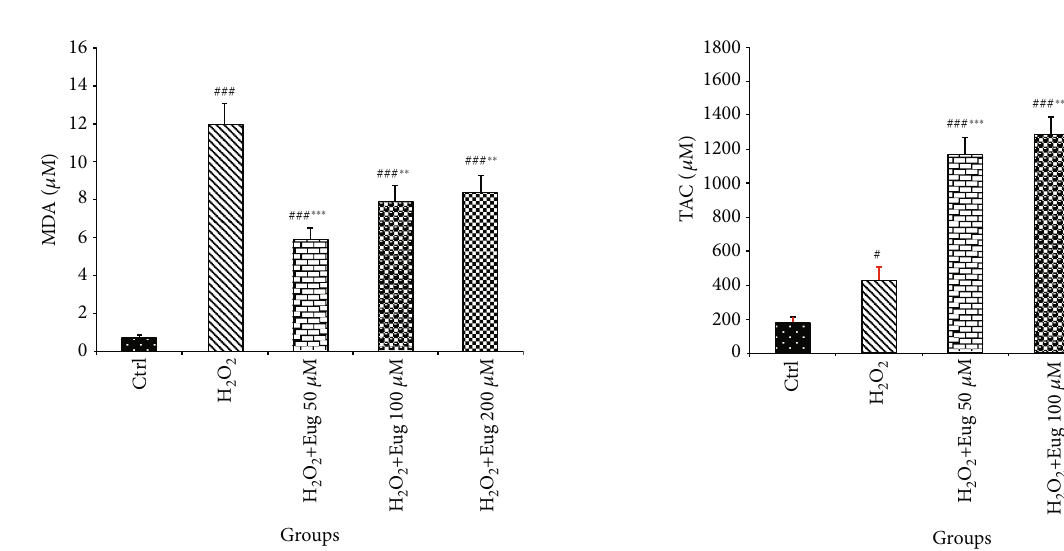
Figure 2: E ff ects of H O and eugenol on the TAC level of islets of 2 2 Langerhans. Data are expressed as the mean ± SE , n = 6 (7 islets in each sample). # P < 0 : 05 and ### P < 0 : 001 signi fi cantly di ff erent with the control group; ∗∗∗ P < 0 : 001 signi fi cantly di ff erent with the H O group. Eug: 2 2